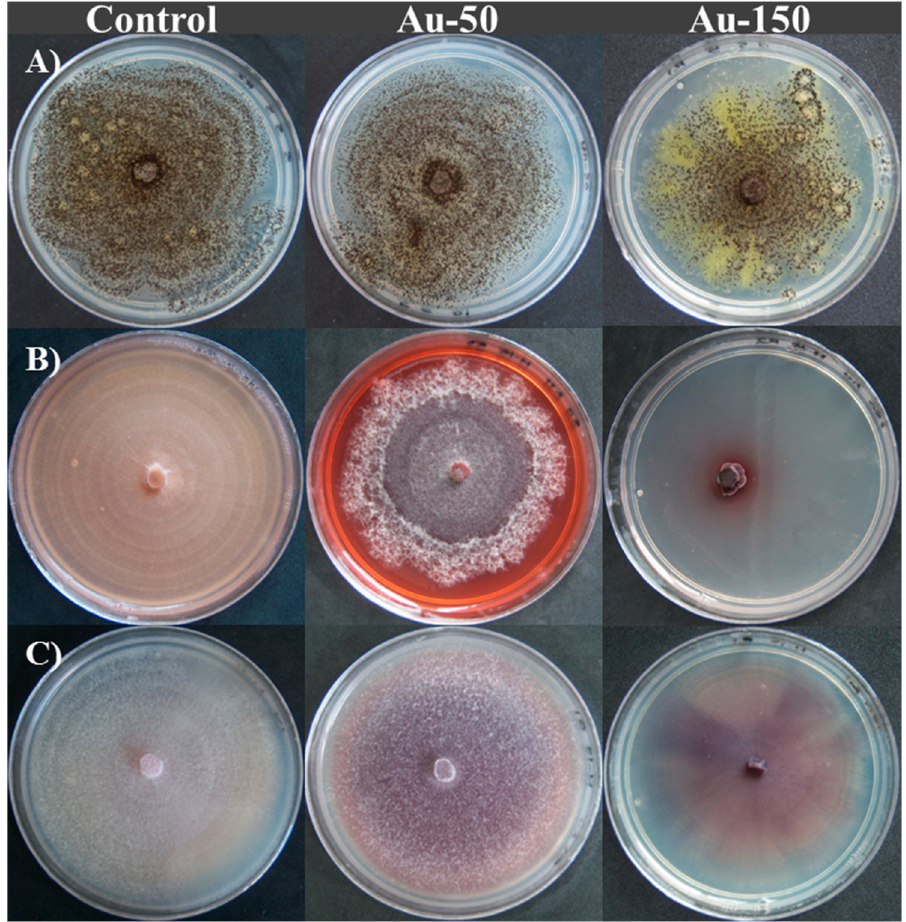
Figure 3. Morphological changes and pigment production by three strains of filamentous fungi exposed to three doses of gold for 20 days. ( A ) Aspergillus niger MX5, ( B ) Fusarium solani MXPE15 and ( C ) Fusarium oxysporum MX17.